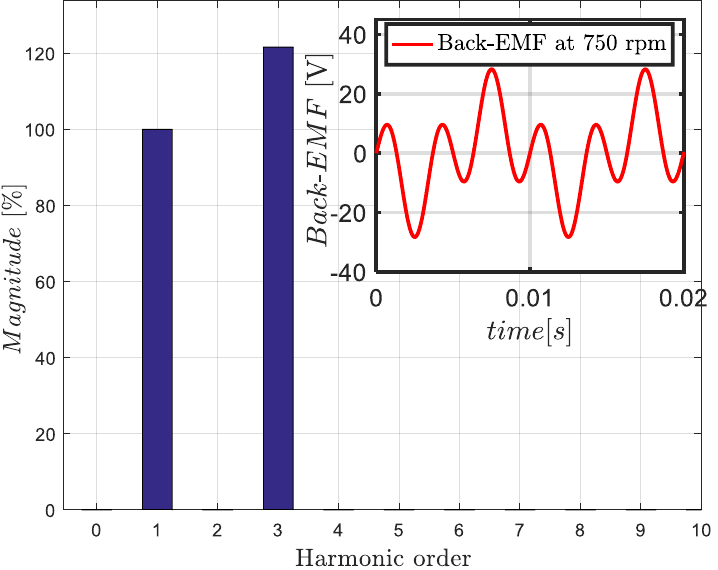
Figure 18. Waveform and harmonic spectrum of the back EMF of phase “a” of the highly non-sinusoidal five-phase PMSM at 78 rad/s.